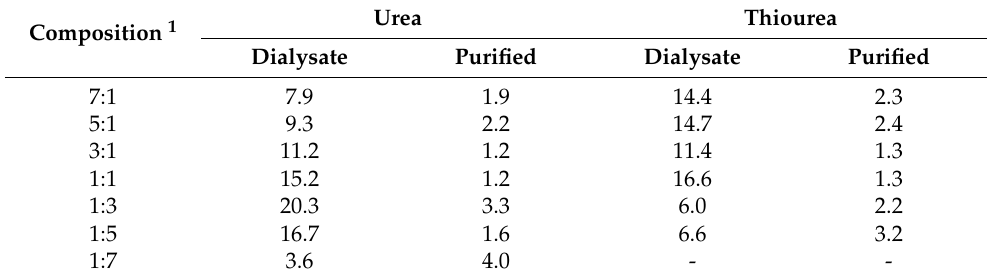
Table 2. Quantum yield of fluorescence (%) of the prepared samples. Excitation wavelength 365 nm. Urea Composition 1